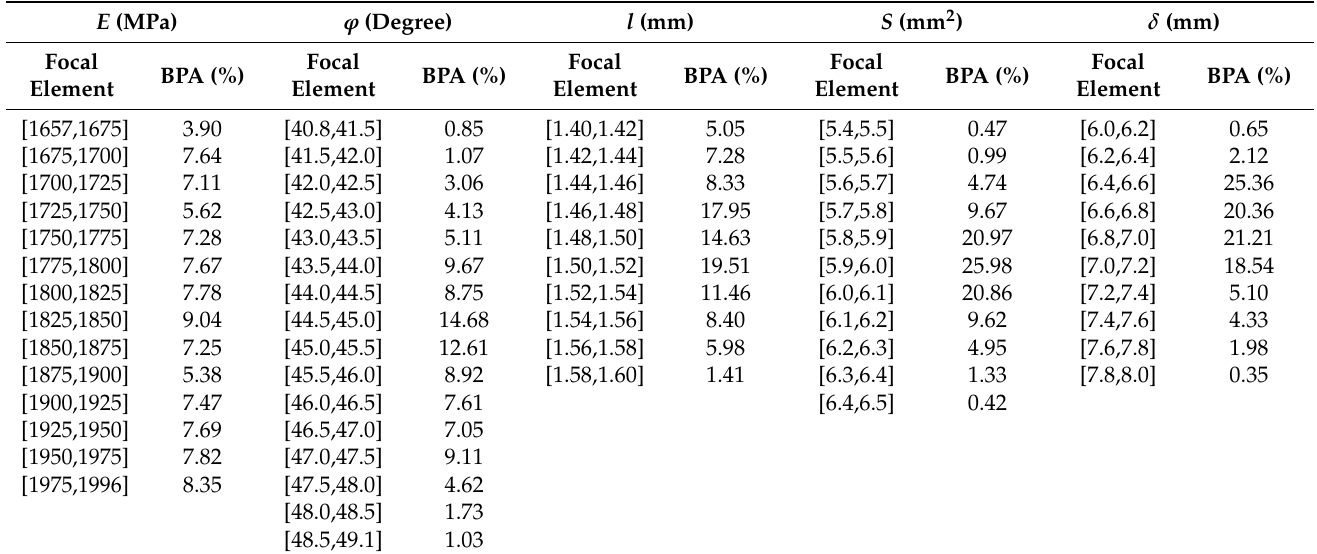
Table 2. Information about the air spring system.